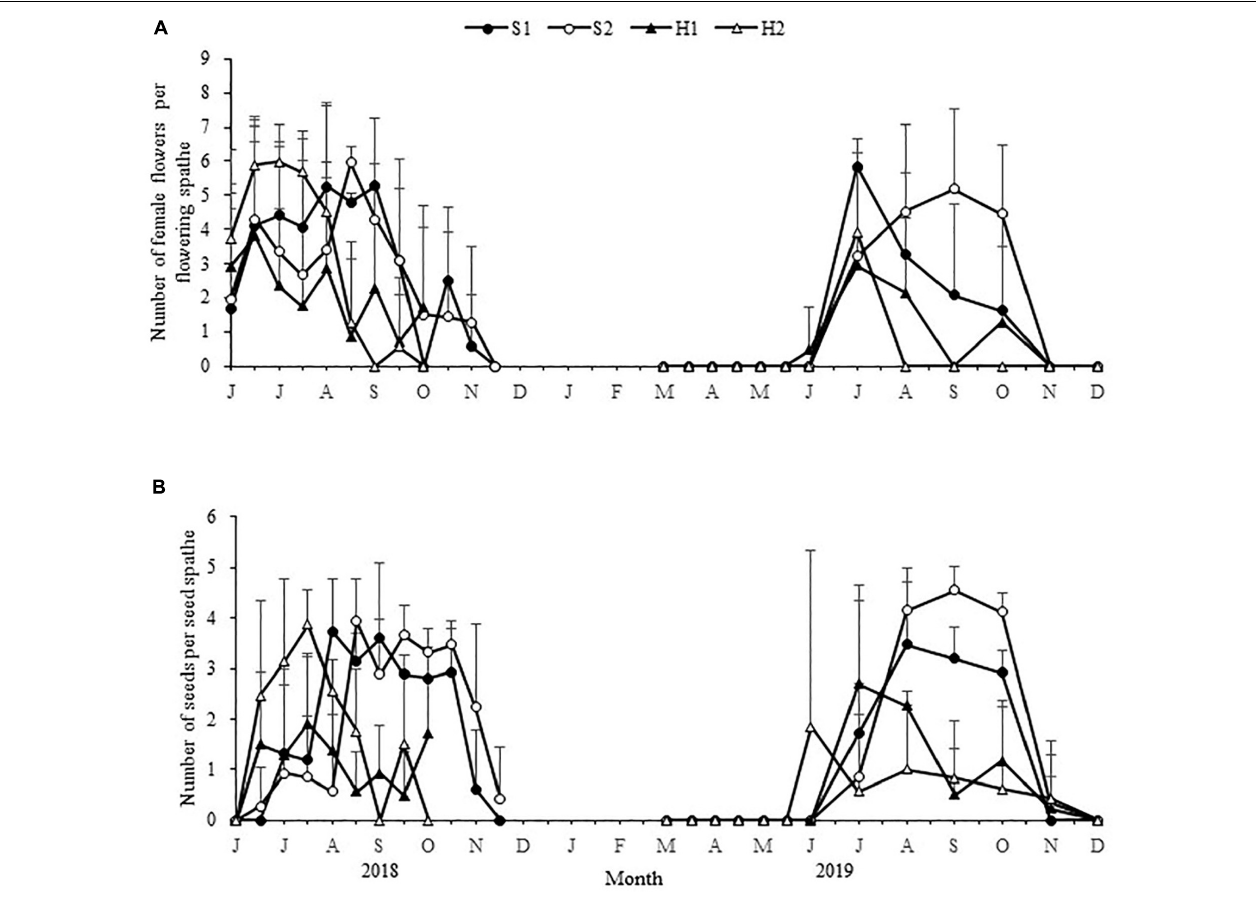
FIGURE 7 | Seasonal changes in the number of Zostera japonica female flowers per flowering spathe (A) and the number of seeds per seed spathe (B) at the four study sites from June 2018 to December 2019. Values are mean ± SD ( N = 7 cores per site).